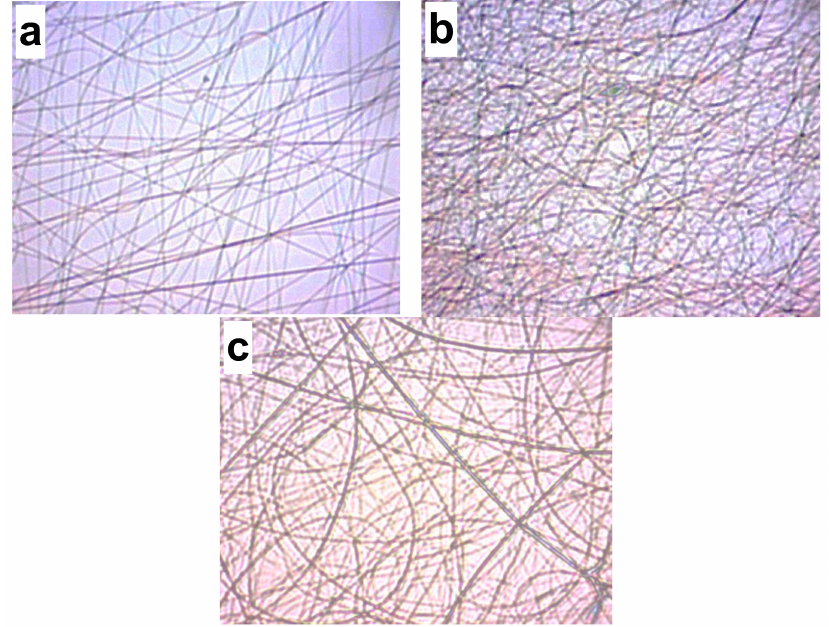
Figure 2. Micrographs of fibers produced with different CS concentrations (wt %): ( a ) 0.5; ( b ) 1; and ( c ) 2 with a voltage, distance, and flow rate of 0.13 mL/h, 20 cm, and 16 kV, respectively (40 ×